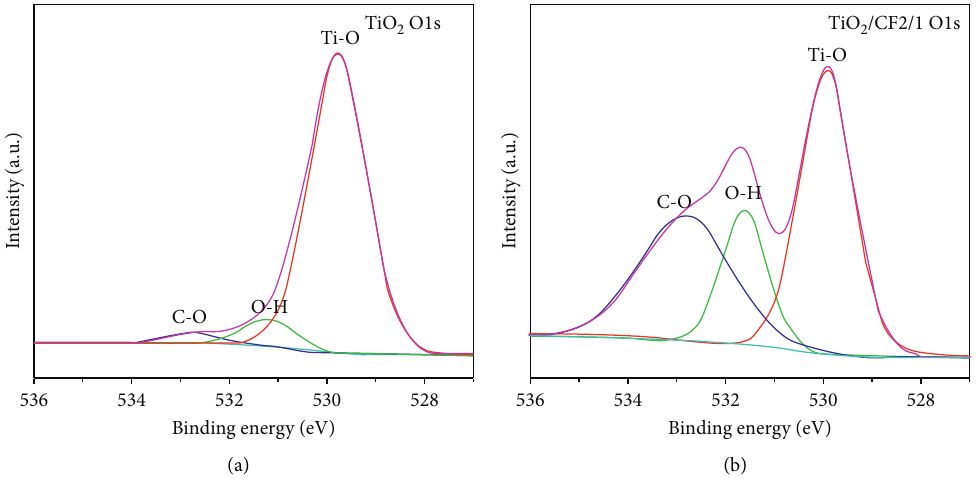
Figure 7: O 1s XPS spectra of (a) TiO